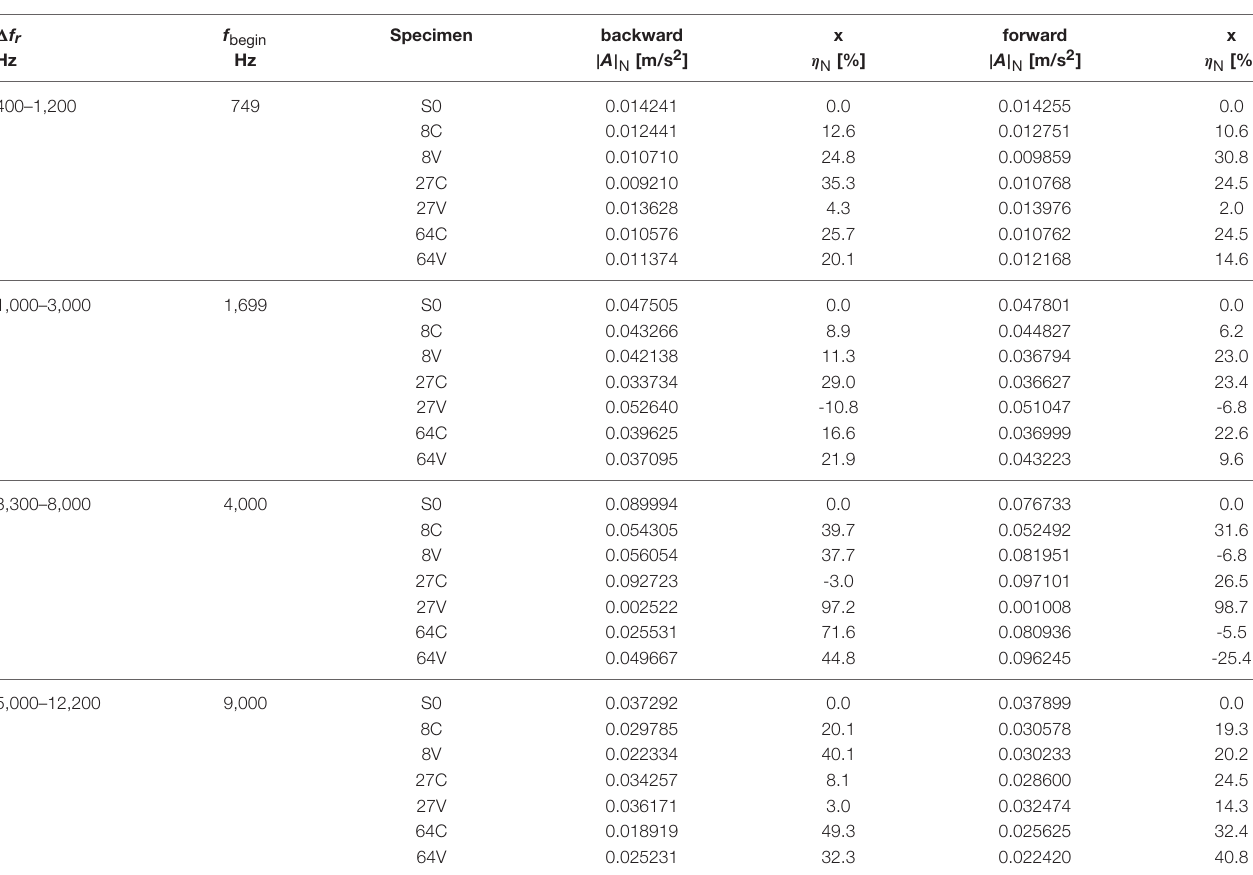
TABLE 3 | Attenuation performance of specimens characterized by different both inclusion spacings and cement cover for linear swept-sine excitations along the x -axis, backward and forward. 1 f